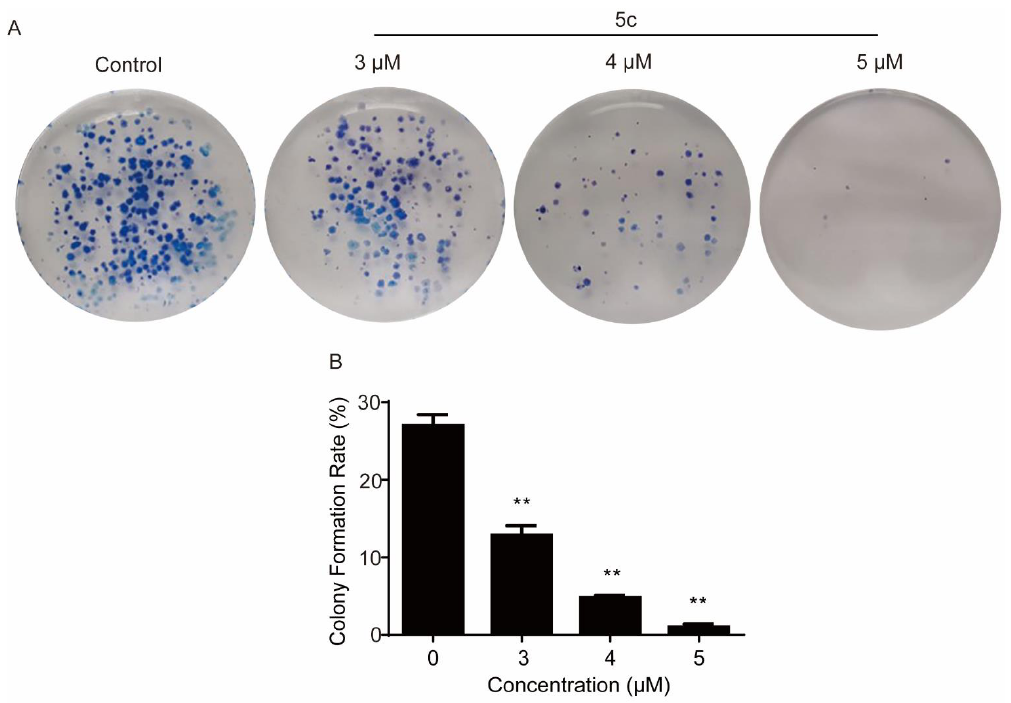
Figure 5. Compound 5c inhibited the colony formation of HeLa cells. ( A ) Colony formation assay. HeLa cells were treated with compound 5c at different doses. Afterward, the medium was replaced with a drug-free medium, and the cells were cultured for 14 days. ( B ) The colony formation rate (%) was quantified by counting the number of colonies in each well. Values are presented as the means ± SDs from three independent experiments. ns = not significant, ** p < 0.01.